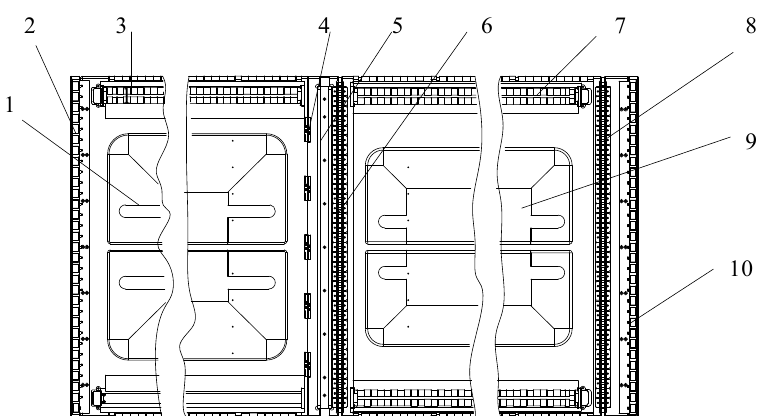
Figure 12. Fracture diagram of the structural design of the moving panel; 1—the back-lifting plate; 2—the slide rail on the left; 3—the lower belt of the back-lifting plate; 4—the hinge; 5—the positioning slide; 6—the flanged chain on the left; 7—the lower belt of the horizontal plate; 8—the flanged chain on the right; 9—the horizontal plate; 10—the slide rail on the right.